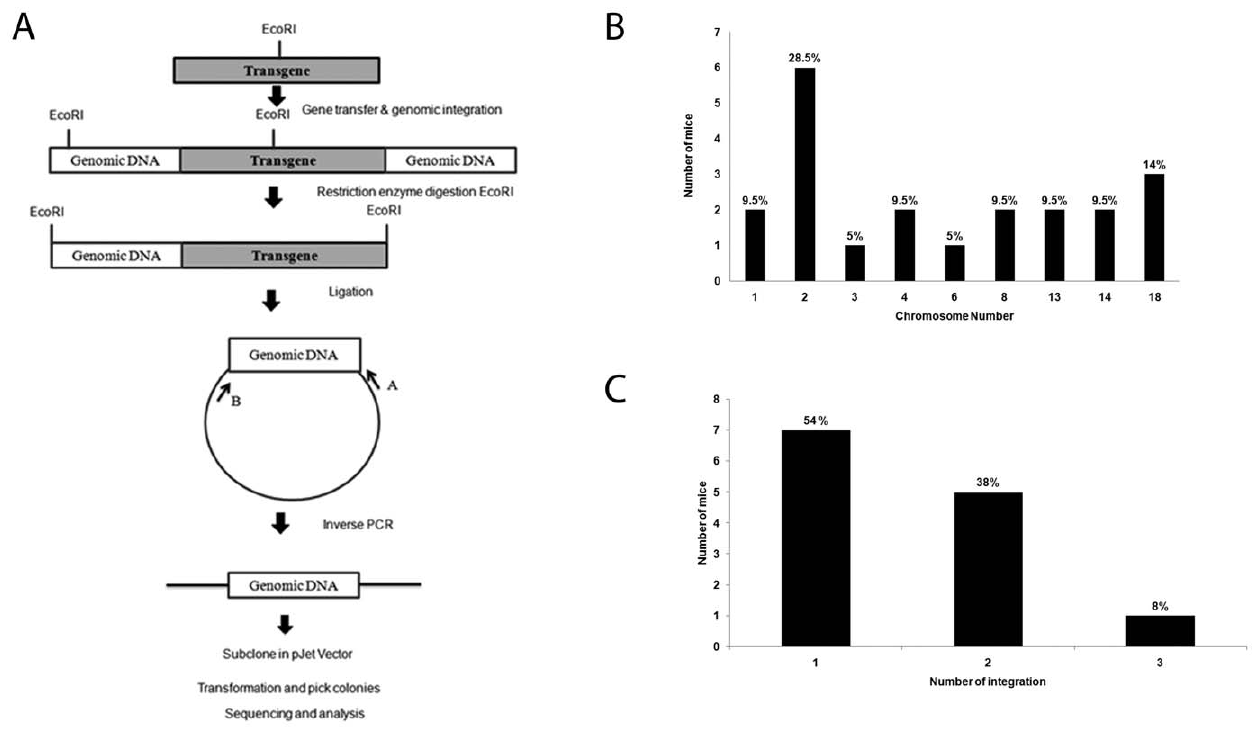
Figure 3. Analysis of integration events in the EGFP-f transgenic mice. A . Protocol for the identification of integration sites. B . Graph showing the frequency of integration events observed in the transgenic animals. Chromosome number is on the X-axis and the number of mice showing integration in the respective chromosomes is on the Y-axis. The number above each bar in the graph indicates the percentage of total integration events analyzed on each chromosome. C . Graph showing the number of integration events in each mouse. No of integration events is on the X-axis and number of mice on the Y-axis. The number above each bar indicates the percentage of mice with one, two or three integration events.